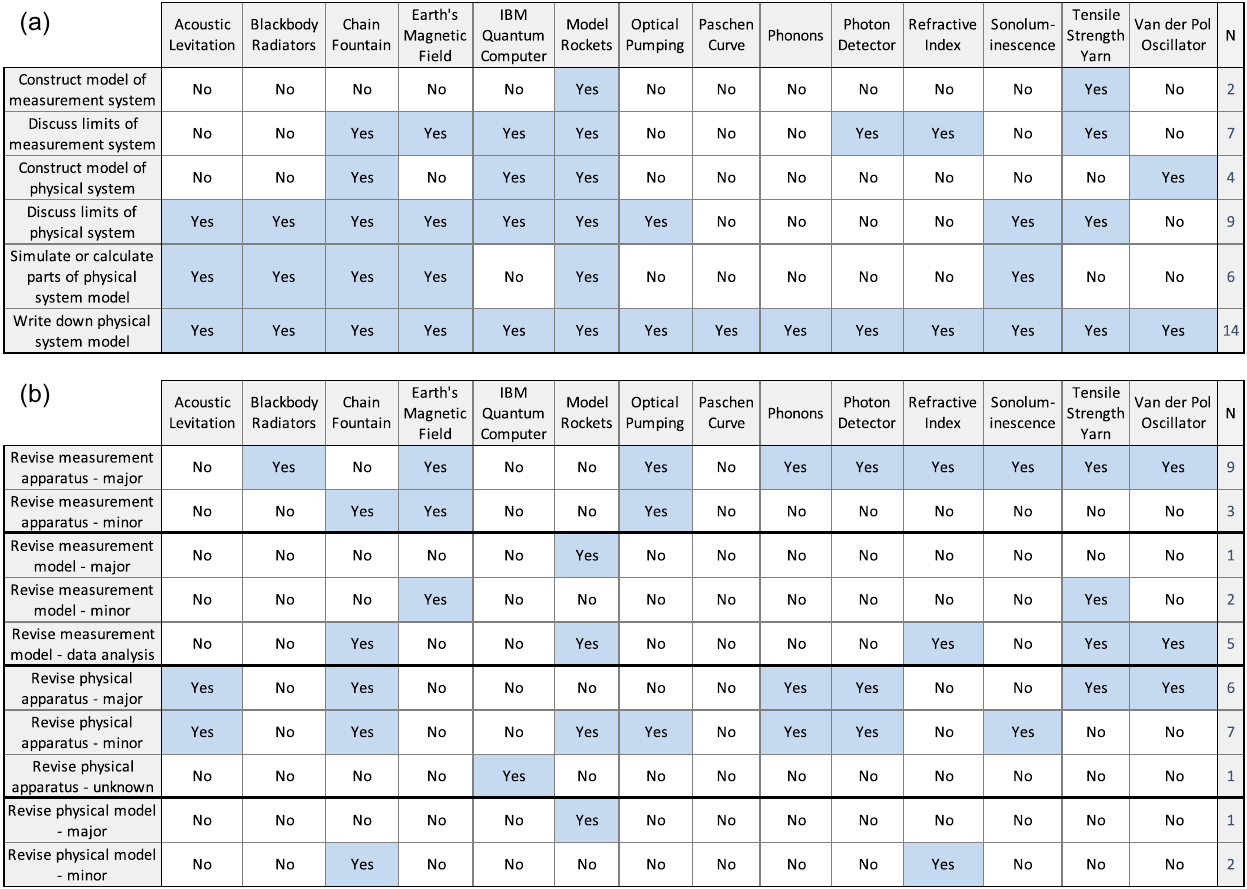
FIG. 5. Presence ( “ yes, ” blue) or absence ( “ no, ” white) of emergent subcodes for the main modeling codes (a) engage with models and (b) revisions in each of the 14 projects. The number of projects that show evidence of each subcode are listed in the far-right